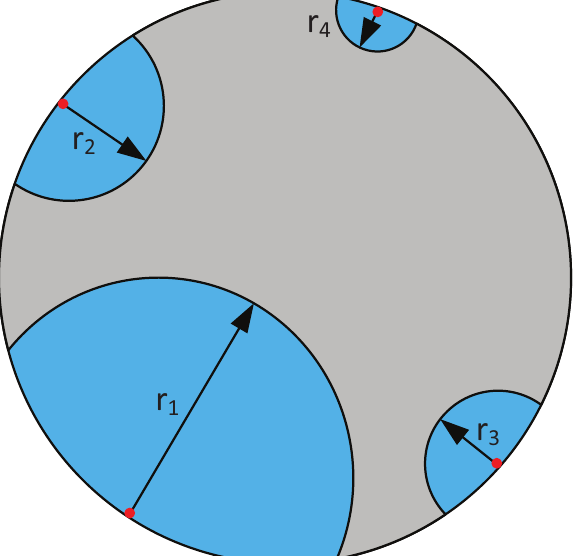
Figure 12. Schematic 2D representation of the penetration depth r i that originates from nuclei i , with i = 1:4. Nuclei are indicated with red dots. The blue areas indicate hydrated K 2 CO 3 ; the grey areas indicate anhydrous K 2 CO 3